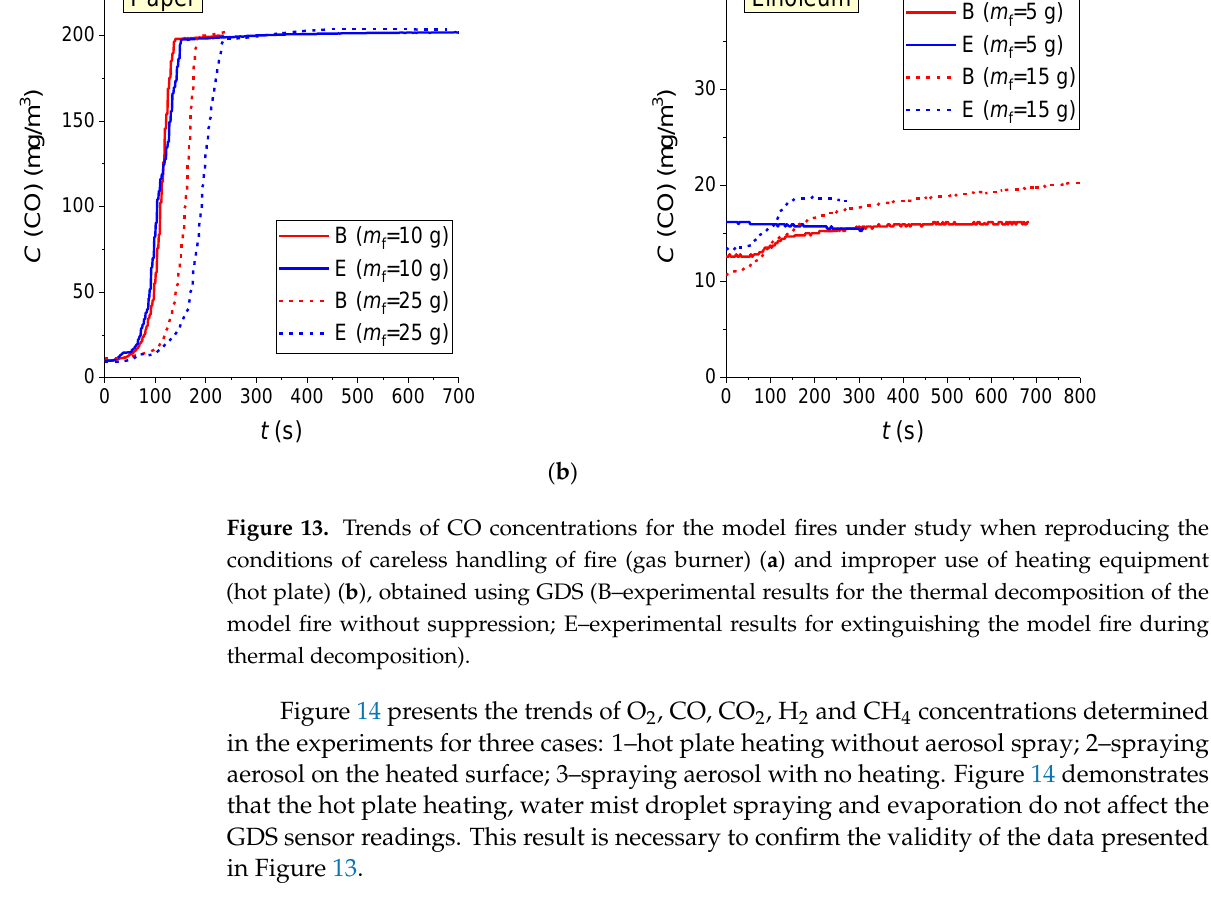
GDS sensor readings. This result is necessary to confirm the validity of the data presented in Figure 13.